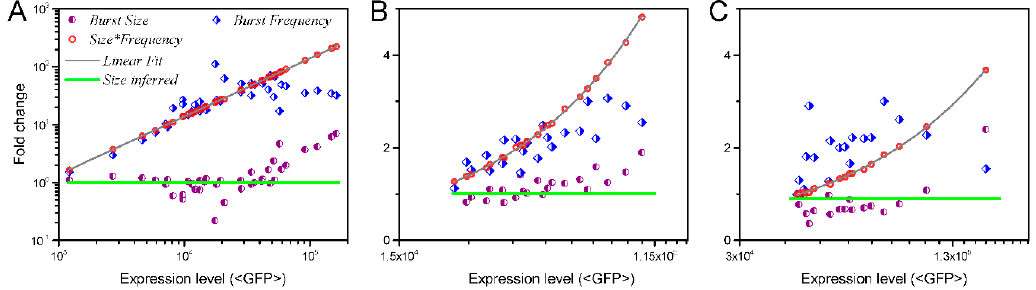
Figure 4. Data supporting size modulation intrinsically support frequency modulation. The measured burst size and frequency of three genes LTR (HIV-1 long terminal repeat), UBC (human elongation factor 1 α ), and EF1A (human ubiquitin C) are separately presented in panels ( A – C ); the data are from [16]. For each gene, the product of burst size and frequency was fitted by a linear function, and the inferred burst size maintained constant.